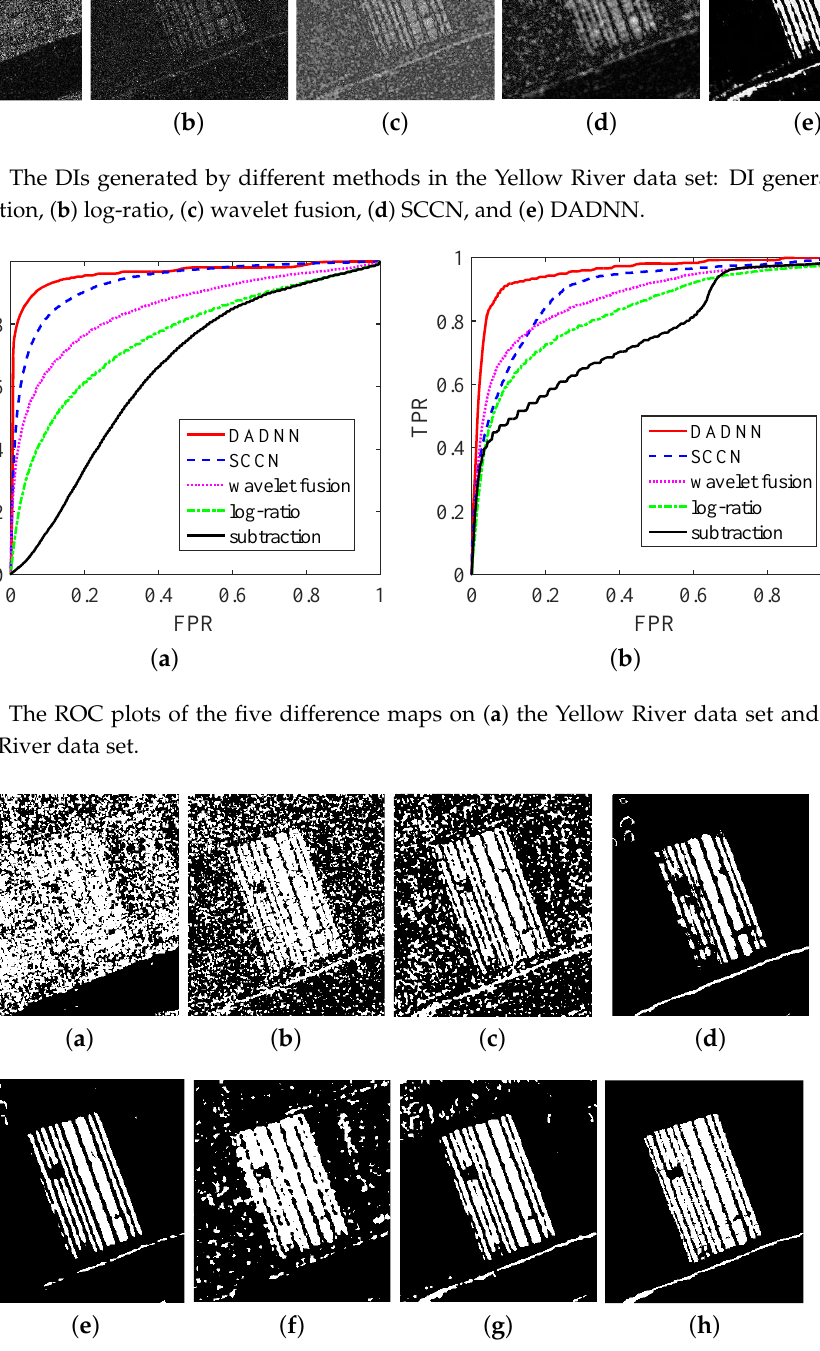
Figure 22. Change detection results obtained by different methods in the Yellow River data set: ( a ) subtraction, ( b ) log-ratio, ( c ) wavelet fusion, ( d ) DNN, ( e ) SSCNN, ( f ) SCCN, ( g ) DADNN, and ( h ) ground